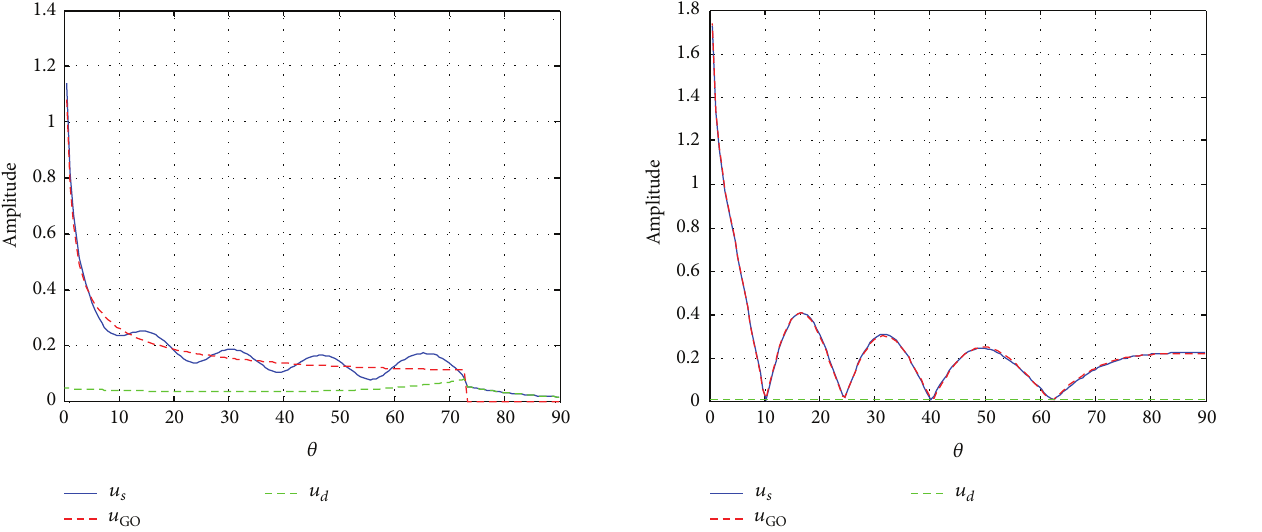
Figure 3: Scattered represented by 𝑢 𝑠 , geometric optics represented , and diffracted represented by 𝑢 𝑑 fields. The observation by 𝑢 GO distance 𝑟 is 3𝜆 and the aperture size 𝑎 is 2𝜆 .